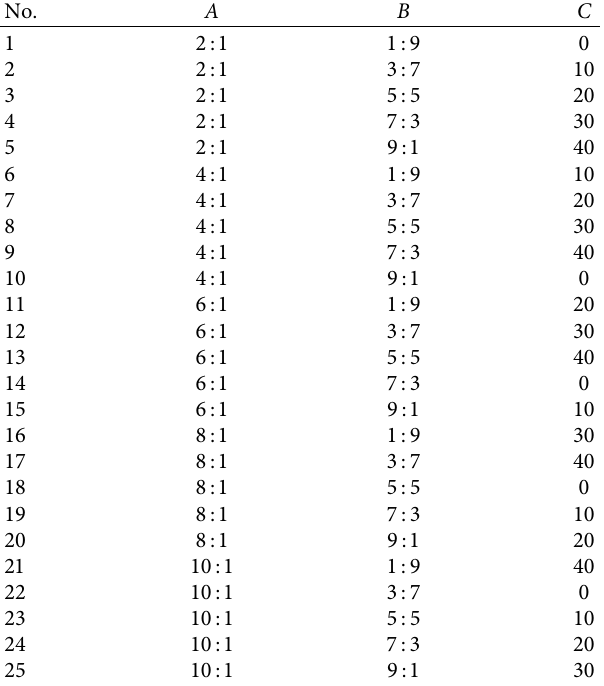
Table 8: Proportioning scheme of similar materials.